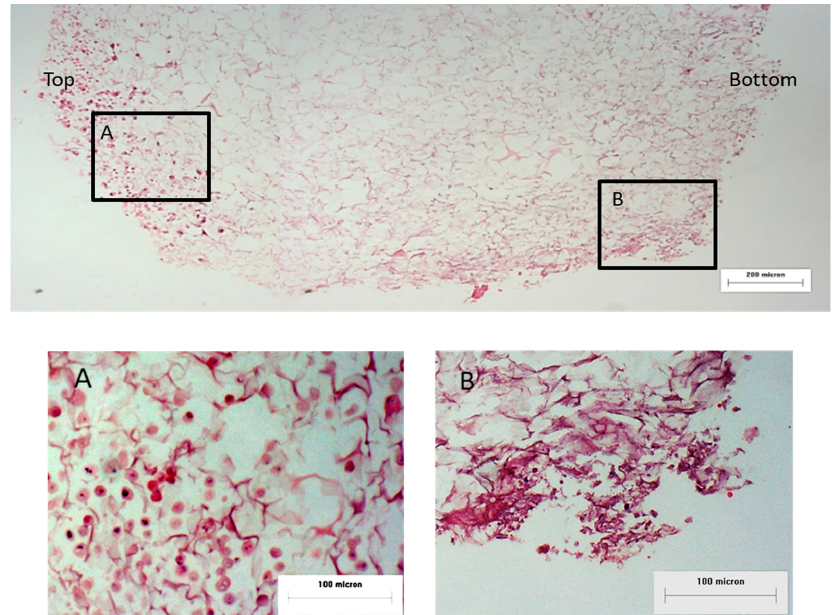
Figure 3. Cross-section view of the hematoxylin and eosin (H&E)-stained 3D human RE construct: ( A ) top layer of collagen construct with RECs and ( B ) bottom layer of collagen scaffold with fibroblasts. The cells were found to enter and migrate into the collagen scaffold at 4 weeks post cell seeding. The presence of distinct RECs and fibroblasts layers on the collagen scaffold was con- firmed by the immunostaining analysis. As the anti-collagen type I antibody bound to the collagen scaffold as well as the seeded fibroblasts, it was difficult to identify the presence of fibroblasts based on collagen type I expression. So, the cells with a nucleus stained with DAPI and negative expression of CK 14 were assumed to be the seeded fibroblasts on the collagen scaffold. We found that the RECs and fibroblast co-existed in the same area and the RECs had not yet migrated to form a separate layer (Figure 4).